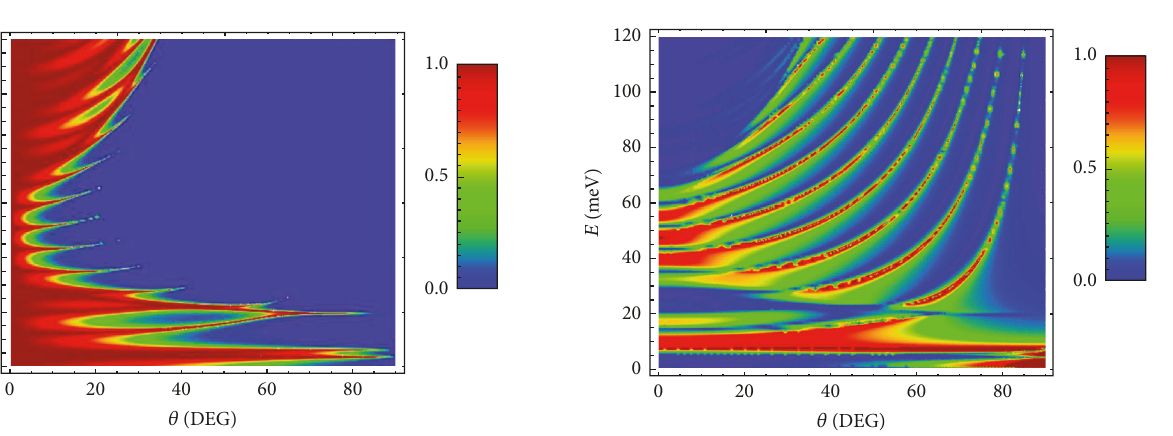
Figure 7: (Color online) Polarization for a double